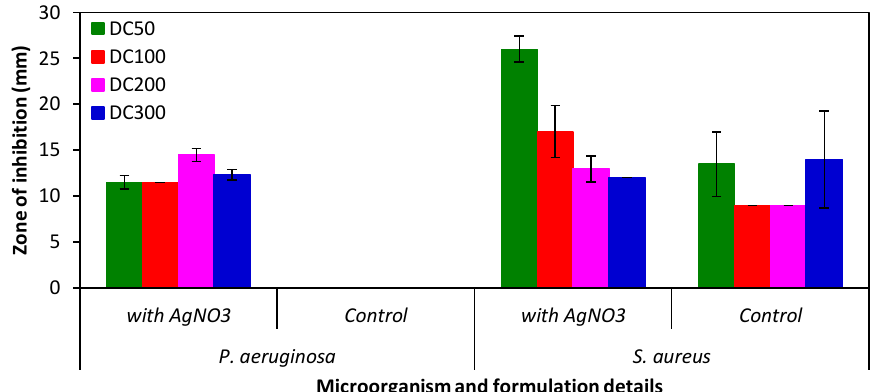
Figure 8. Antimicrobial potential of AgNO 3 loaded hydrogels indicated as the zone of inhibition (ZOI) against P. aeruginosa (Gram negative) and S. aureus (Gram positive). Diameter of the well = 5 mm; n = 3; error bars = standard deviation.